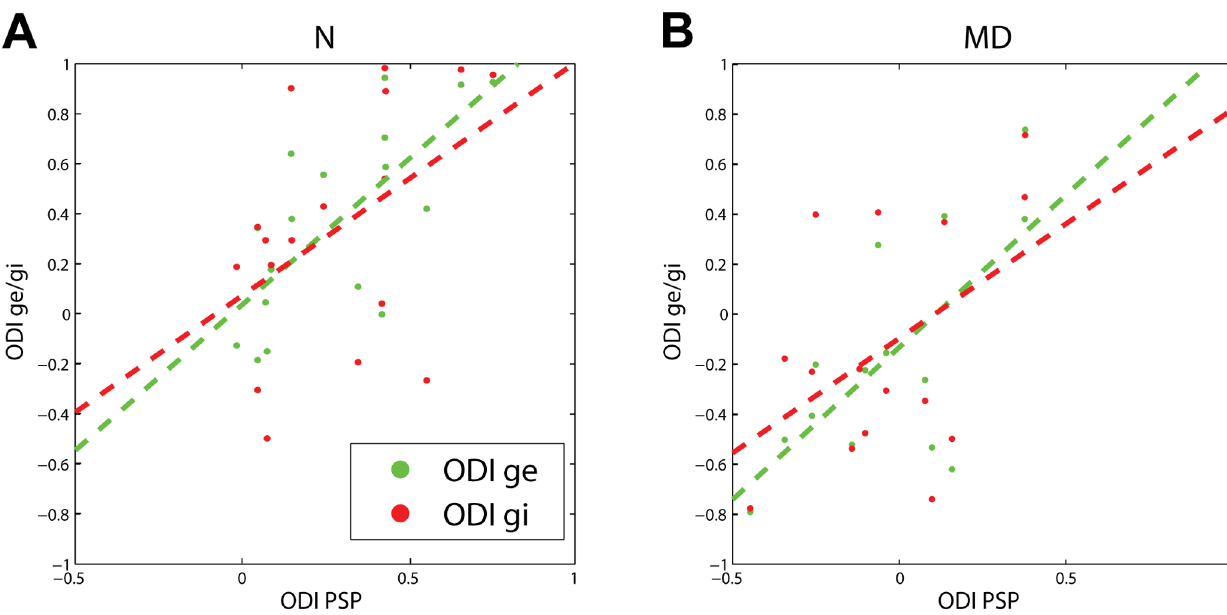
Figure 5. Relationship between synaptic and conductance-based ODIs. A . Raster plot showing the relationship between synaptic ODIs (ODI PSP) and ODIs for excitatory and inhibitory conductances (respectively ODI ge, in green and ODI gi, in red), for animal in the control (N) group. Dashed lines indicate the result of the linear fit between synaptic and conductance-based ODIs (ODI-ge vs. ODI-PSP: r=0.73, p , 0.01; ODI-gi vs. ODI- PSP: r=0.47, p=0.06). B . Same as in A for rats in the MD group (ODI-ge vs. ODI-PSP: r=0.67, p , 0.01; ODI-gi vs. ODI-PSP: r=0.47, p=0.06).